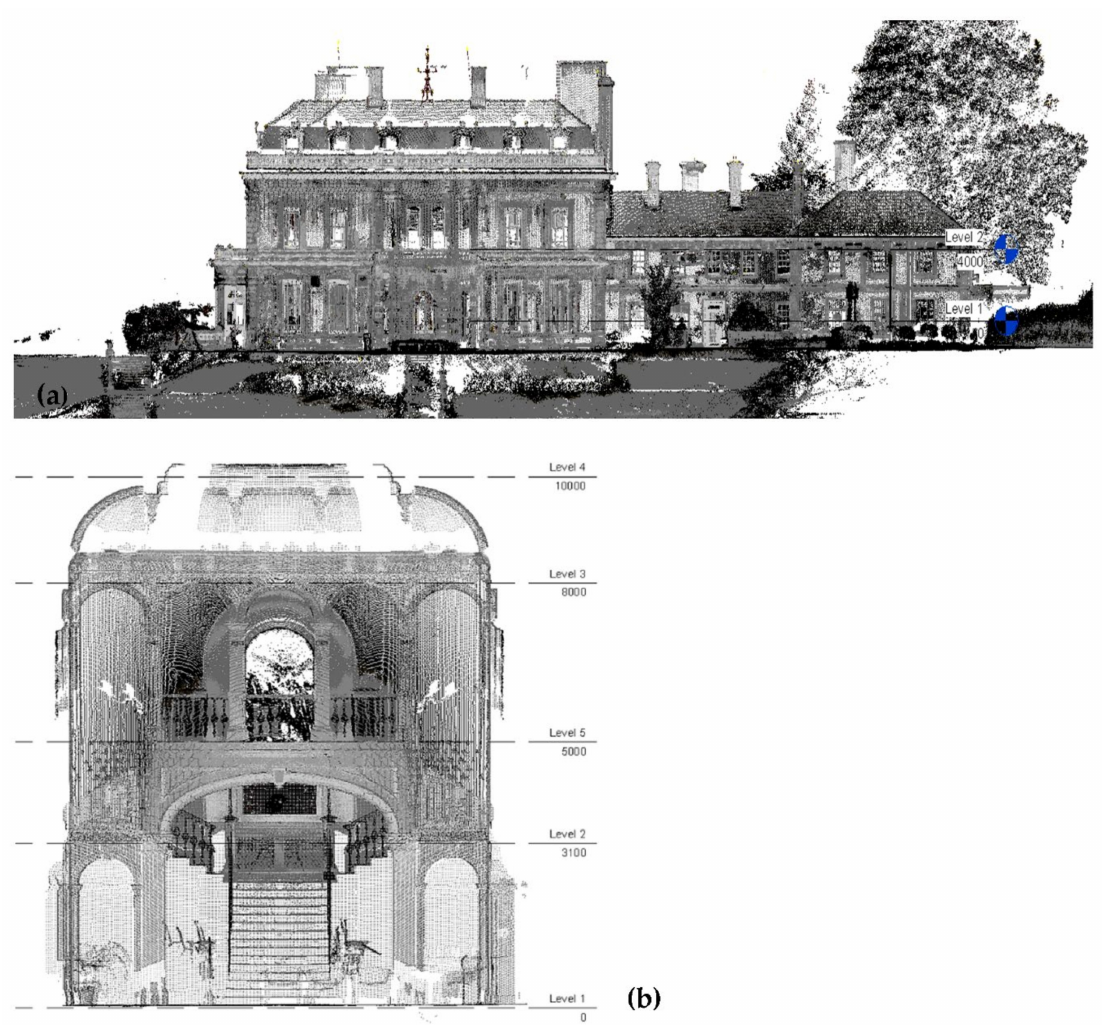
Figure 14. ( a ) Eastern elevation of Headington Hill Building; ( b ) cross-section of the main hall.